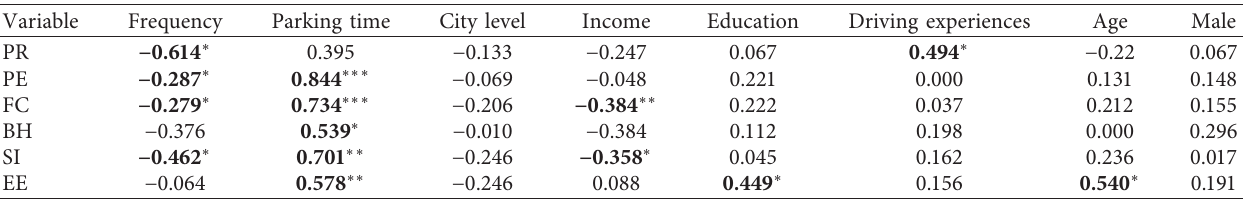
Figure 2: Analysis results of the structural model. Solid line indicates that there is a significant influence relationship; dashed line indicates that there is no significant influence relationship. Table 5: Results of